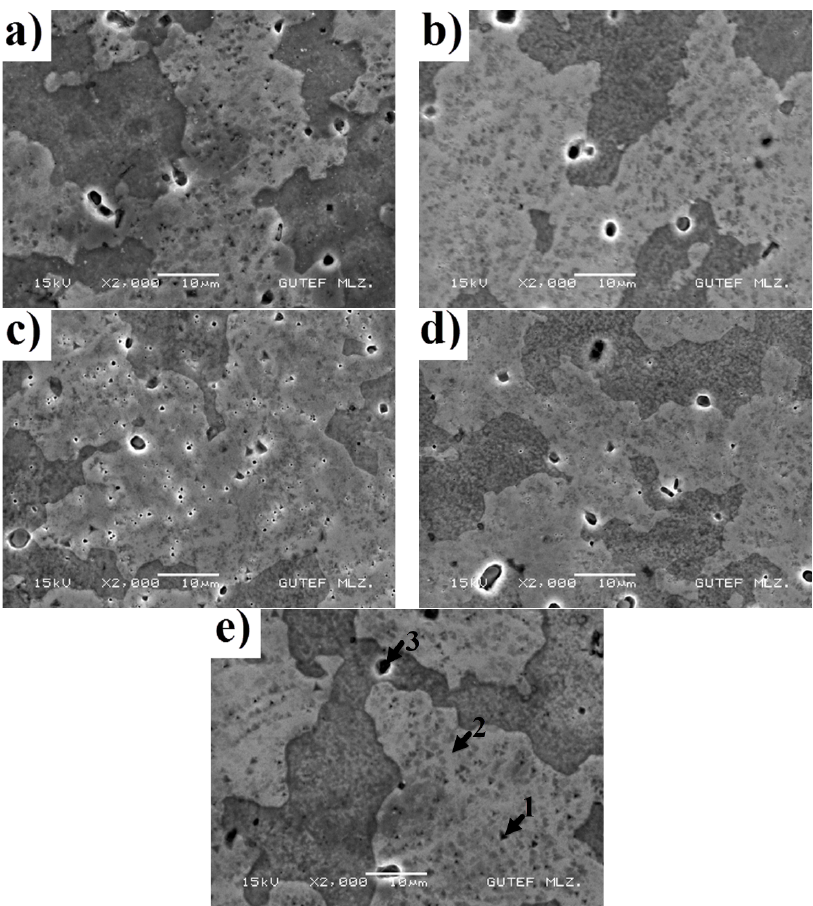
Figure 1: SEM images of the AA7075 alloy aged 120 ∘ C for 24 hours following solid solution at different temperatures of a) 465 ∘ C b) 470 ∘ C c) 475 ∘ C d) 482 ∘ C e) 485 ∘ C.